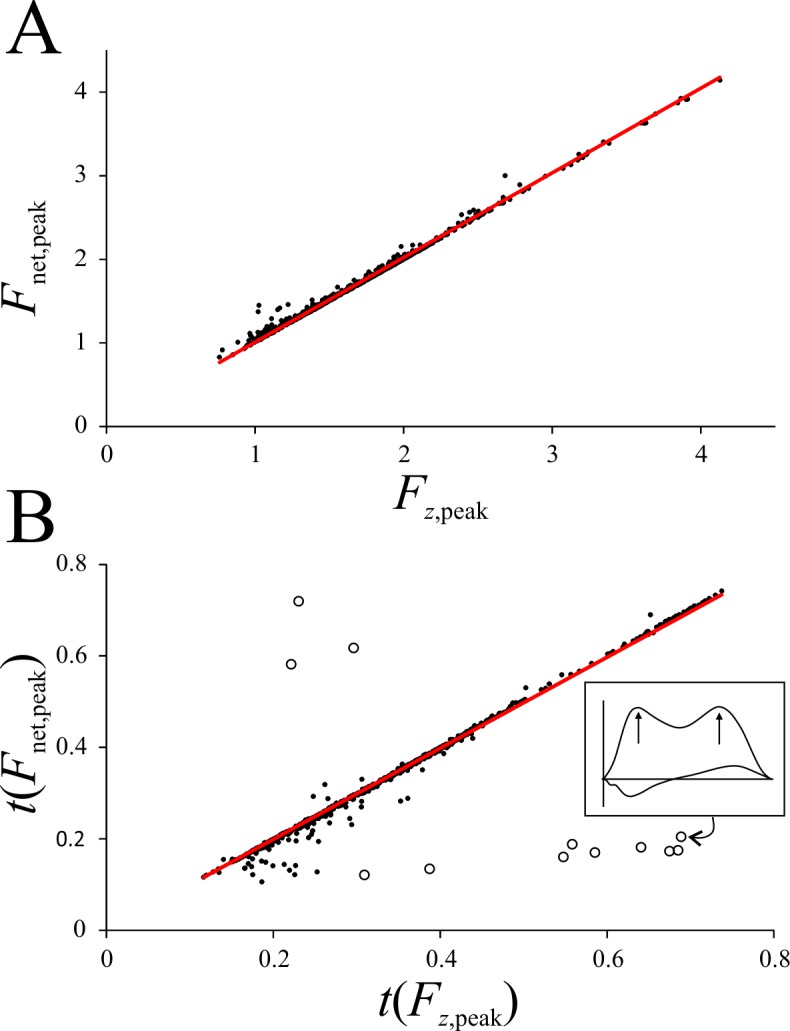
The dominance of the vertical component of the GRF.(A) Peak net force scales very strongly with peak vertical force; major axis line has a slope almost exactly equal to unity. (B) The instance of peak net force is very strongly coincident with the instance of peak vertical force; major axis line has a slope almost exactly equal to unity. In B, the outliers (hollow circles) are slow speed trials in which the two peaks were of almost the same magnitude, such that the peak net force can occur at a very different time to when the vertical component is at a maximum (inset illustrates one such trial).